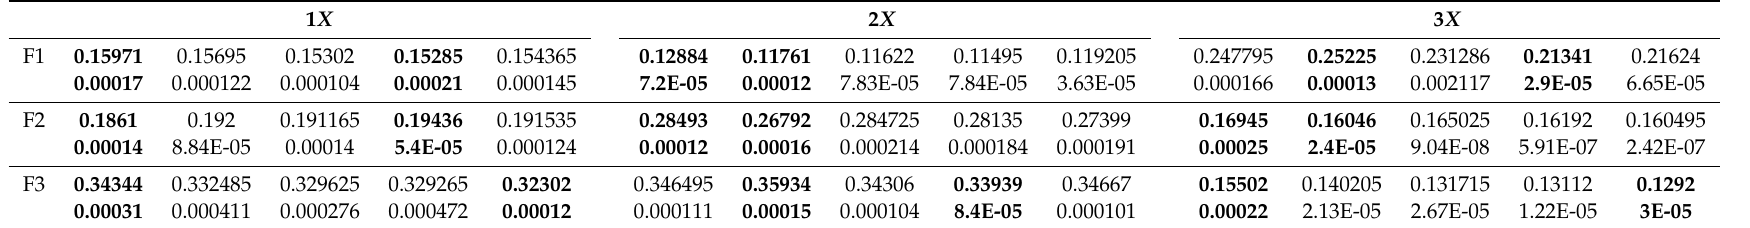
Table 6. The mean values and variances of the measurements under the fault modes [54].